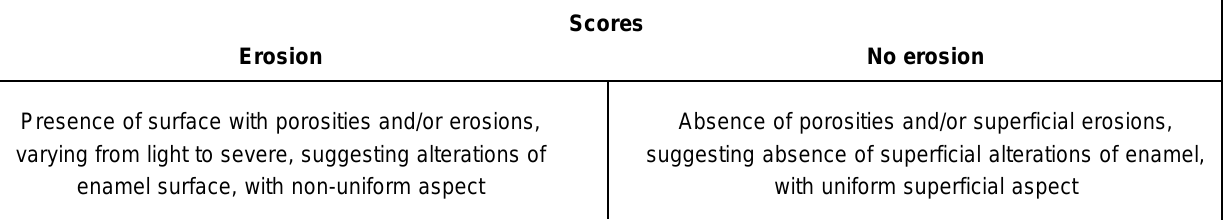
FIGURE 2- Scores attributed by the examiners, according to the type of surface